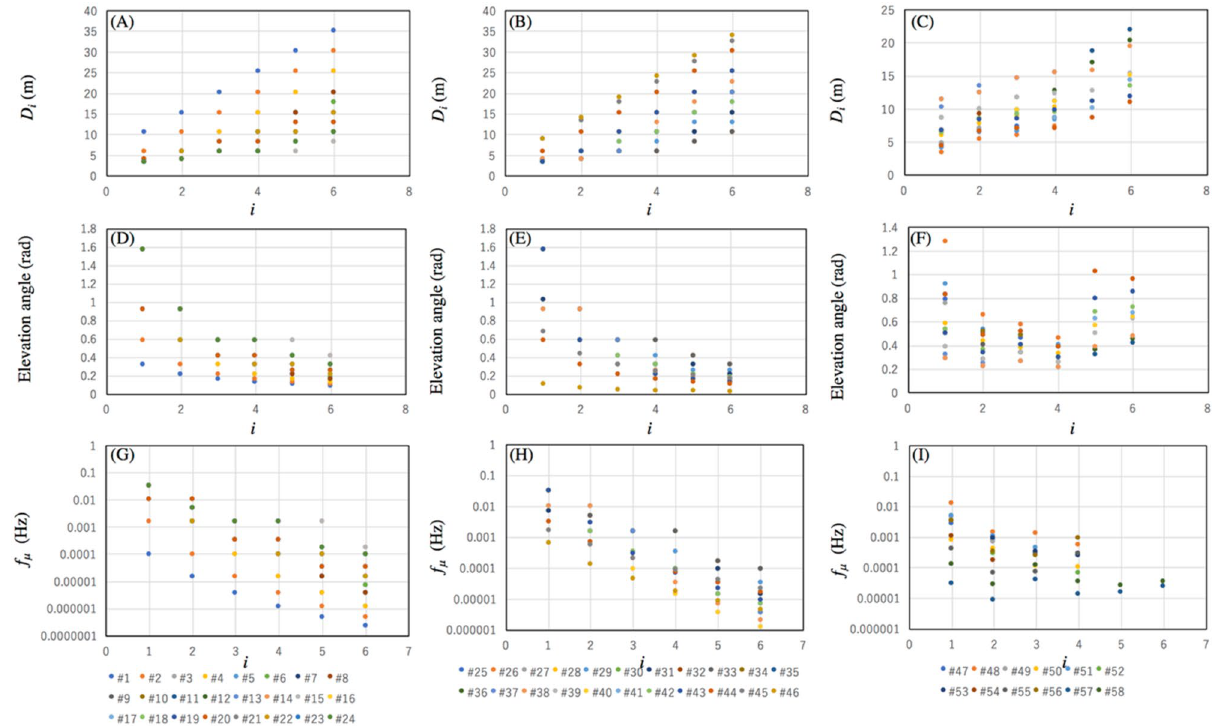
Figure 8. Distribution of inter-nodal distances ( A – C ), inter-nodal elevation angles ( D – F ), and resynchronization frequency at each node ( G , H ) based on the current geometrical configuration of the wireless sensors.